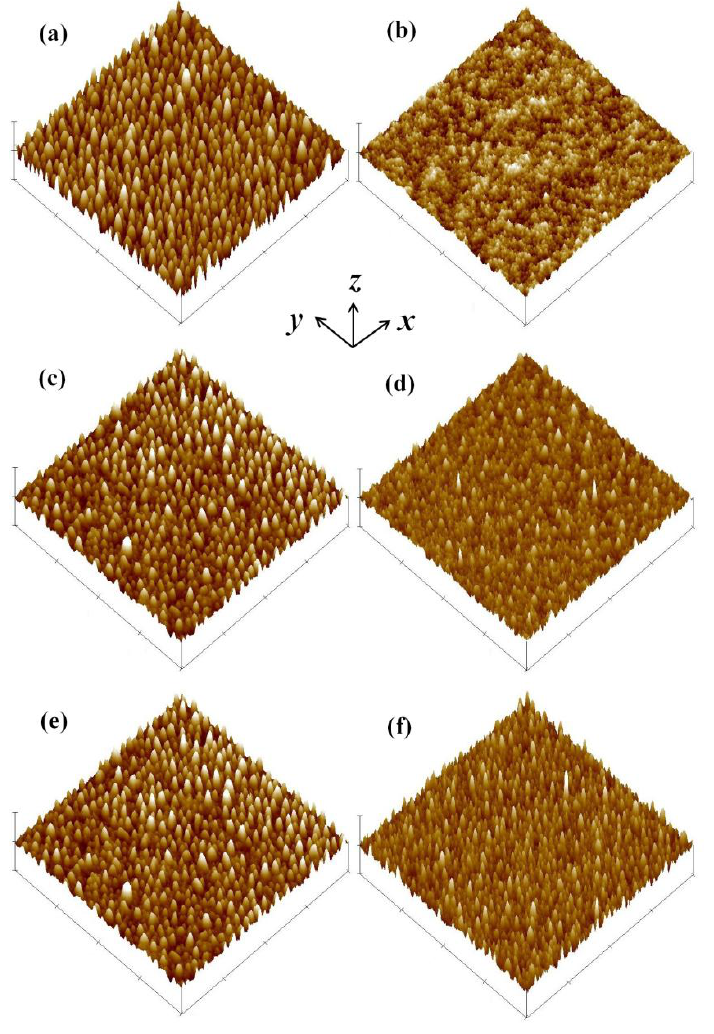
) of the Au resistor for ( a ) before and ( b ) after a values are in the same level for a values are (a) 3.84 nm, (b) 1.24 nm, (c) 2.37 a